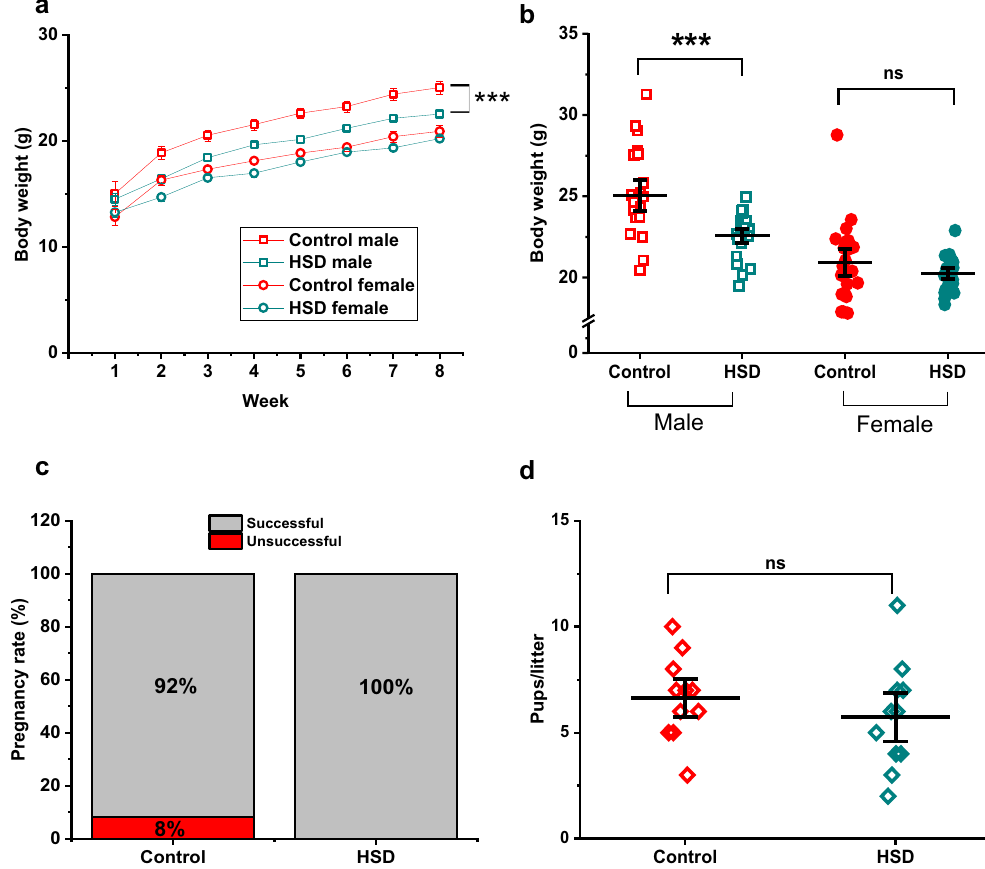
Figure 1. HSD negatively regulates weight in male mice and does not result in reproductive changes in the parental generation. Body weight was measured weekly during the 8-week feeding protocol. ( a ) Each group shows a steady growth although HSD males were significantly smaller (n = 22 control male group, 21 HSD male group, 21 control female group, 22 HSD female group). ( b ) Average body weight at the end of feeding protocol per group. Reproductive health was measured by calculating pregnancy rate ( c ) and quantifying the number of pups per litter ( d ) in each pair (n = 14 control pairs, 15 HSD pairs). Both parameters show that HSD does not alter reproduction ability. Data are described as mean ± SEM. * p < 0.05, ** p < 0.01, *** p < 0.001, unpaired t-test ( d ), one-way ANOVA and Tukey’s test ( b